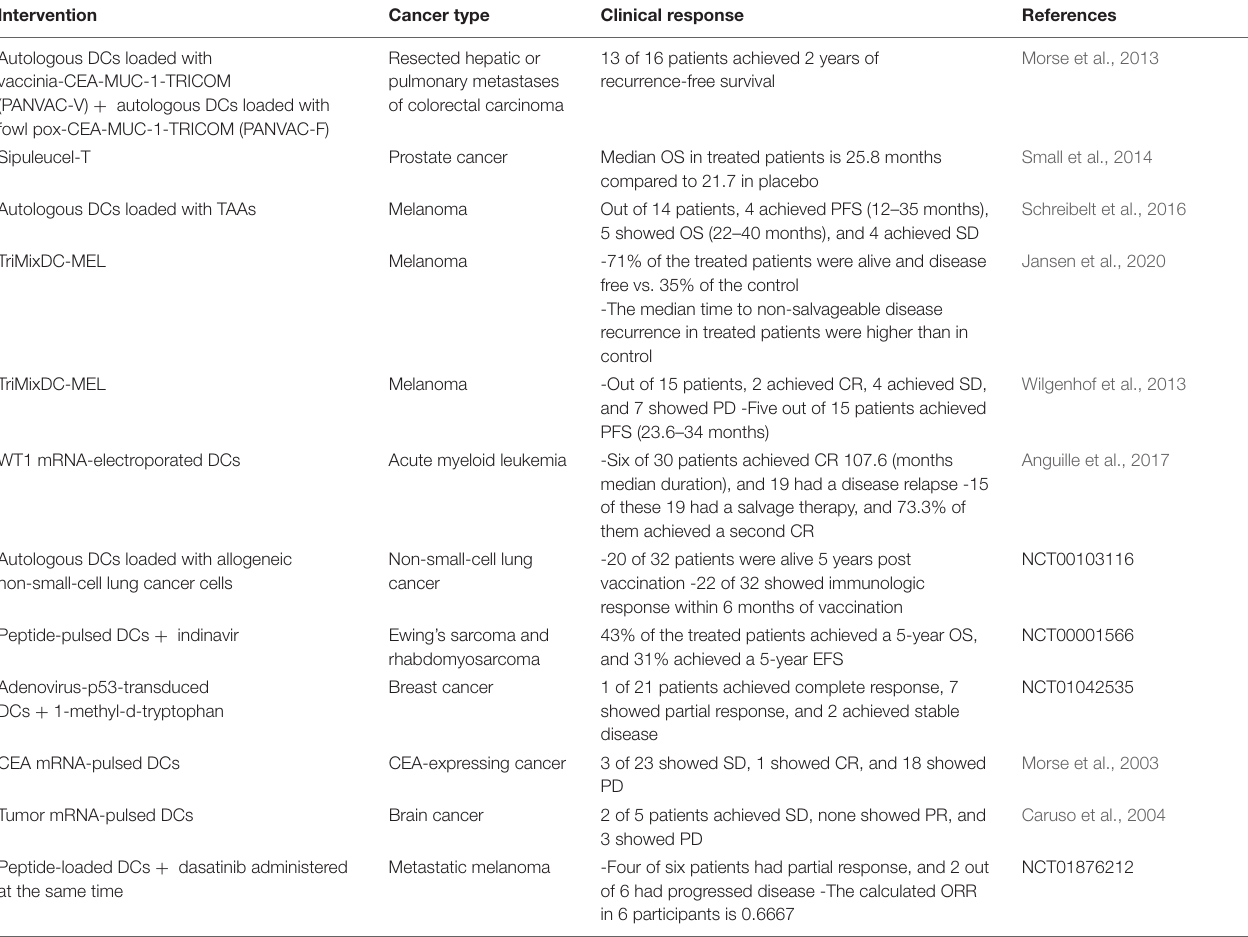
TABLE 1 | Clinical trials utilizing DC vaccines in cancer